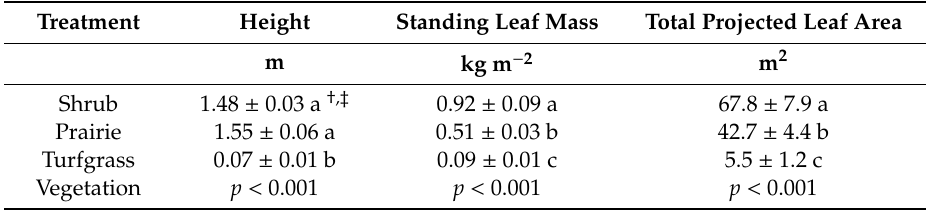
Table 3. Plant height, standing leaf mass, and total projected leaf area of the three vegetation types. Height data are averaged across species within each prairie or shrub vegetative community. Leaf mass and leaf area data are the summation of species data at peak biomass.